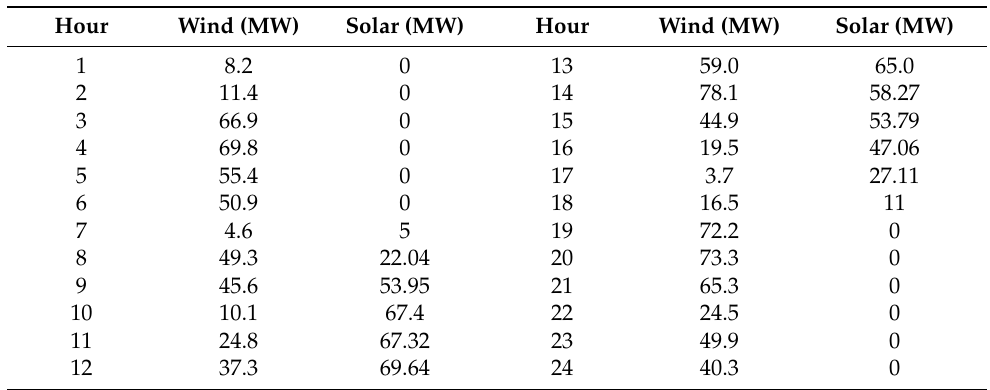
Table 5. RERs (wind, solar) power